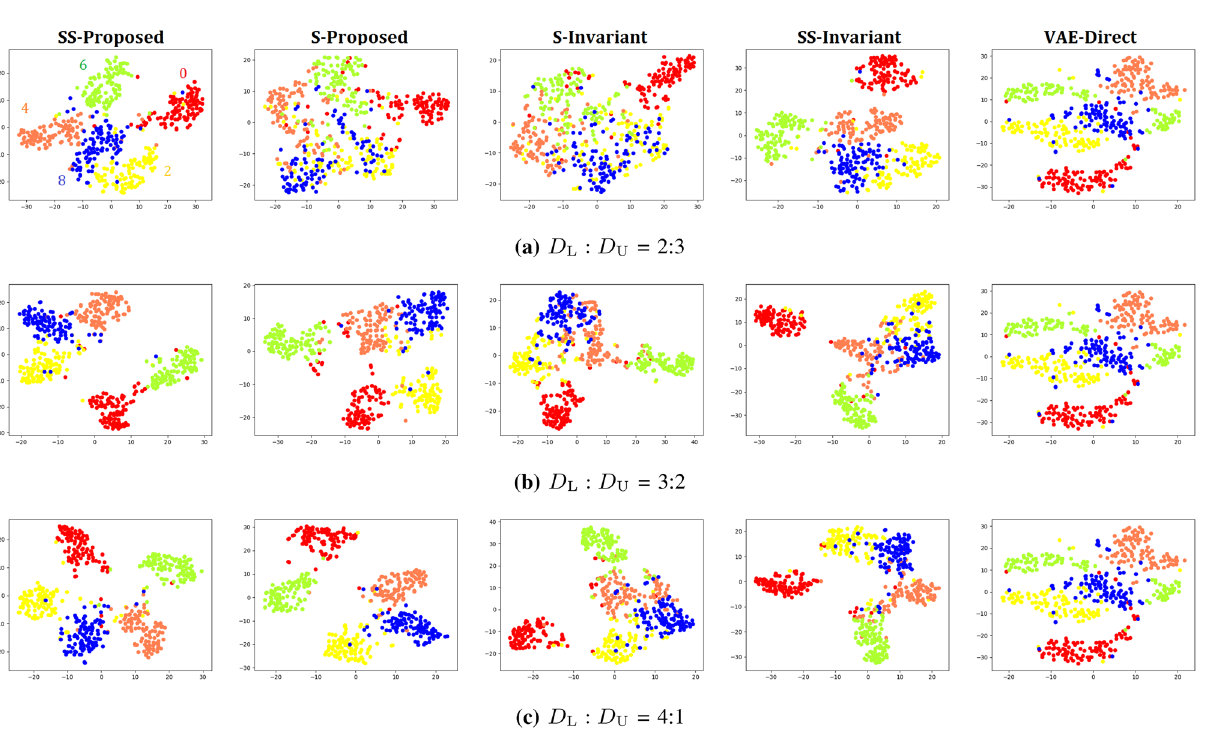
Boldface denotes the best and comparable methods according to the paired t test at the significance level 5%. Bottom row gives the number of best or comparable cases of each